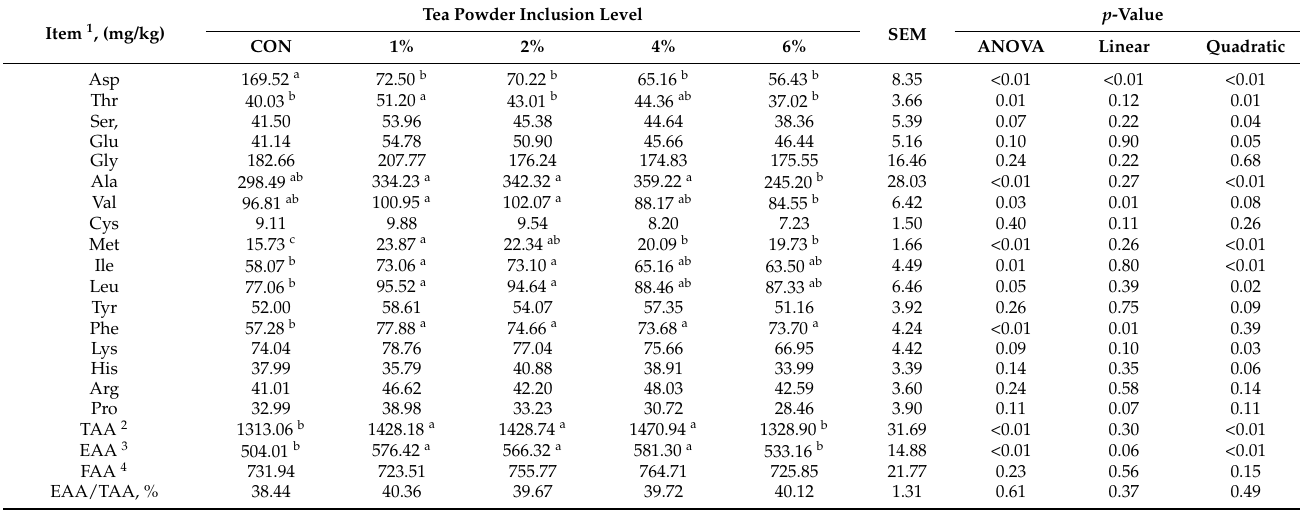
Table 7. Effects of dietary tea powder on free amino acids profile of LD muscle tissue of the pigs. Item 1 , (mg/kg)